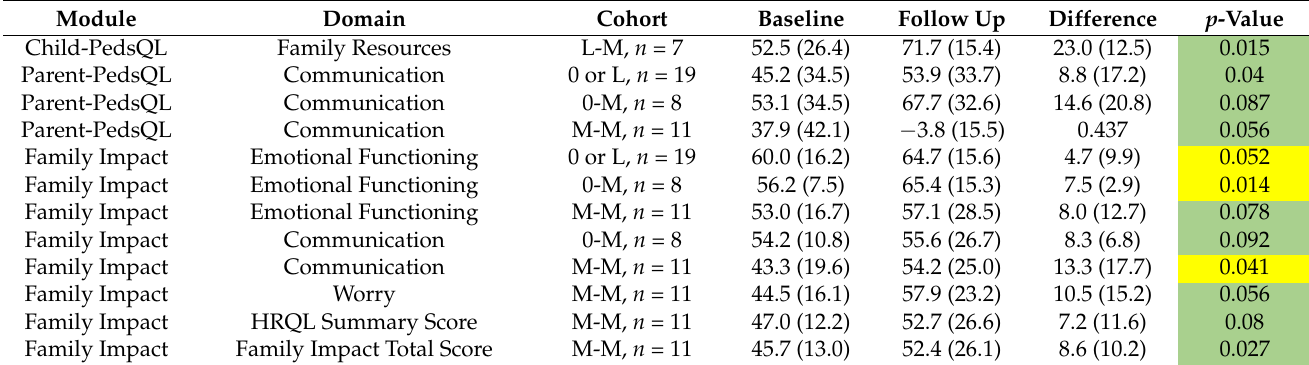
Table 5. Significant Difference in Quality of Life Scales by